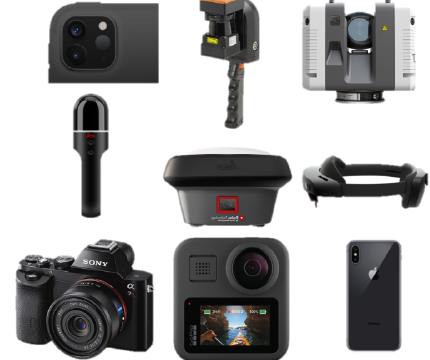
Figure 3: The acquisition systems tested for the project.